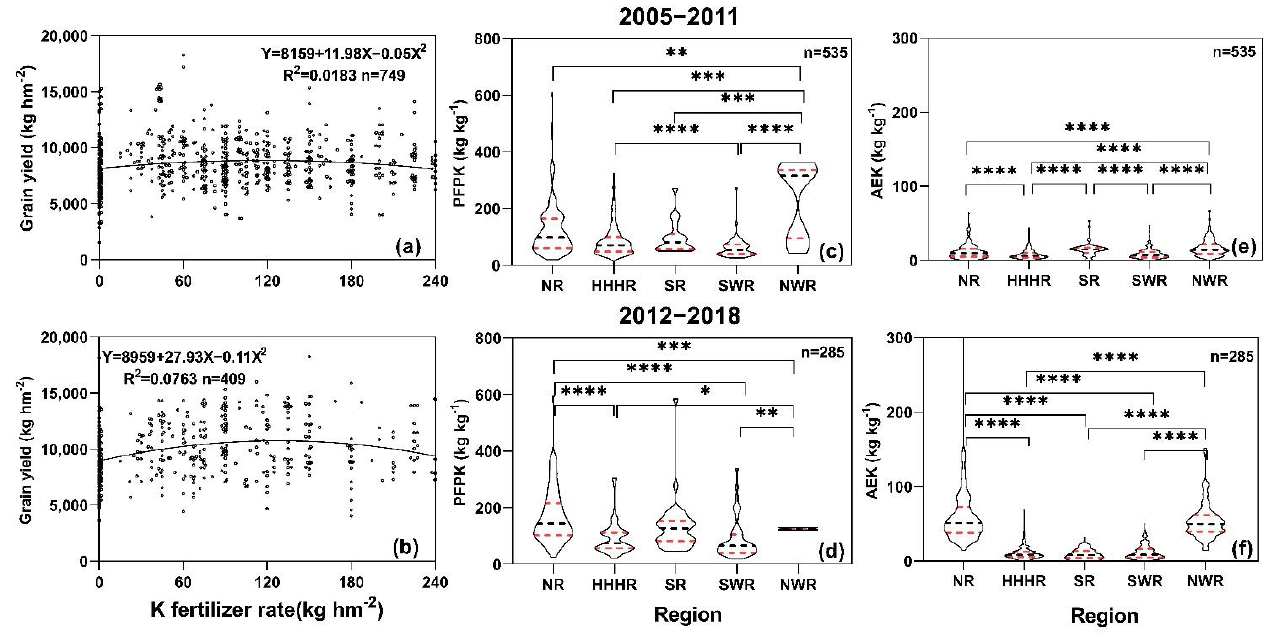
Figure 10. Relationship between maize yield and K fertilization levels in different years ( a , b ), and comparison between the PFPK ( c , d ) and AEK ( e , f ) of five maize-growing regions in China. NR: Northern region; HHHR: Huang-Huai-Hai region; SR: Southern region; SWR: Southwestern region; NWR: Northwestern region. The black dashed lines and red dashed lines indicate the median and quartiles, respectively. *, **, *** and **** represent significance levels of p < 0.05, p < 0.01, p < 0.001, and p < 0.0001, respectively, and an absence of significance-level markings between any pair of regions indicates that their differences were non-significant.